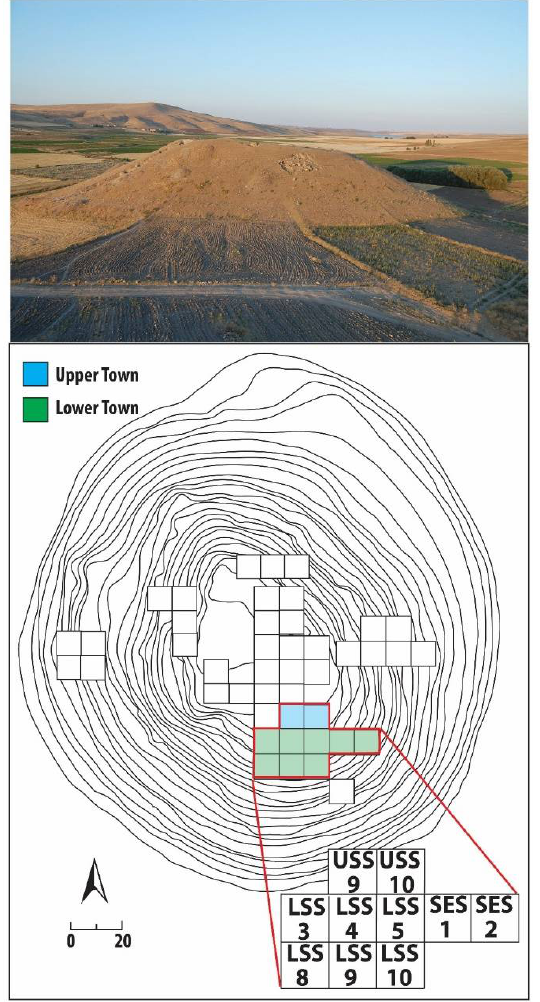
Figure 2. ( Top ) View of Çadır Höyük looking south; ( Bottom ) Topographic map of Çadır Höyük showing areas of excavation. Trenches and areas discussed are labeled and highlighted.